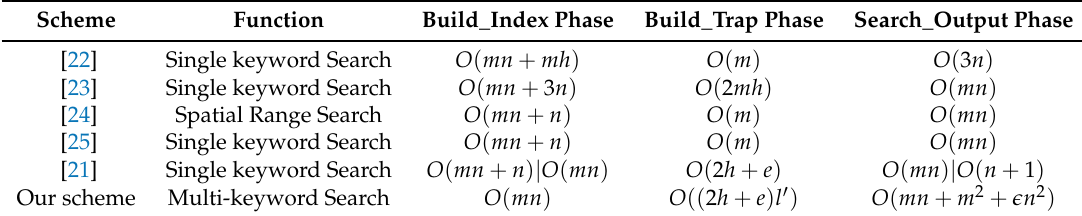
Table 2. Comparisons of function and computational